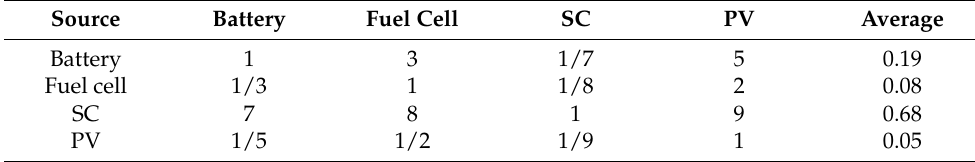
Table 5. Discharge speed relative scores.